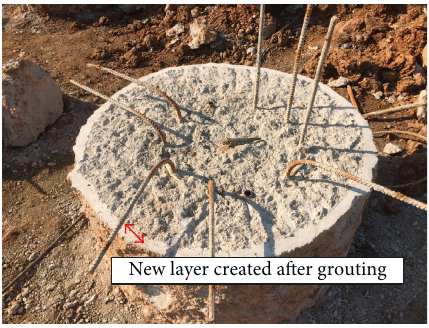
Figure 1: Postgrouted concrete